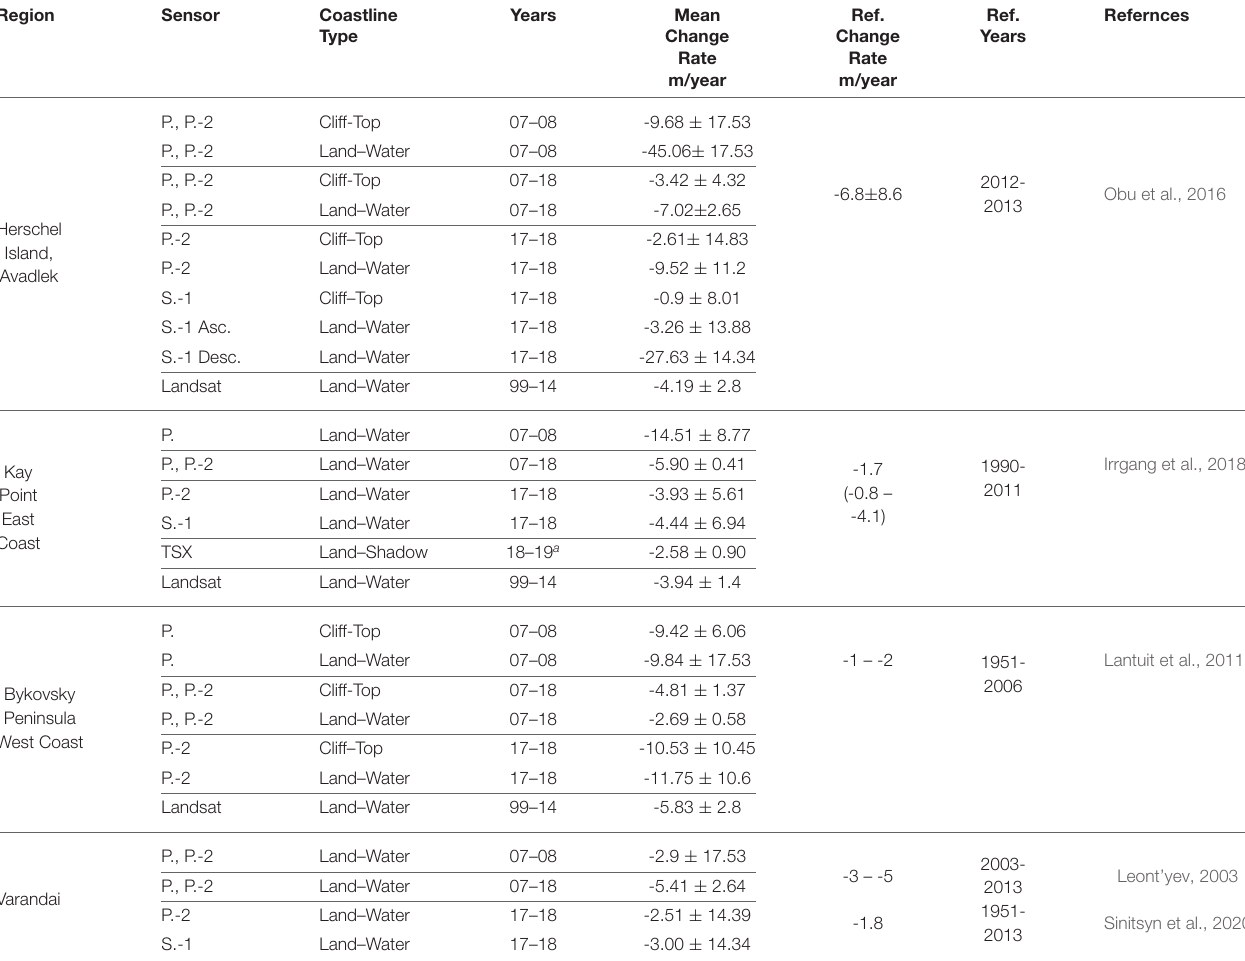
TABLE 5 | Summary of the shoreline movement results grouped by region. Region Sensor Coastline Years Mean Ref. Ref.